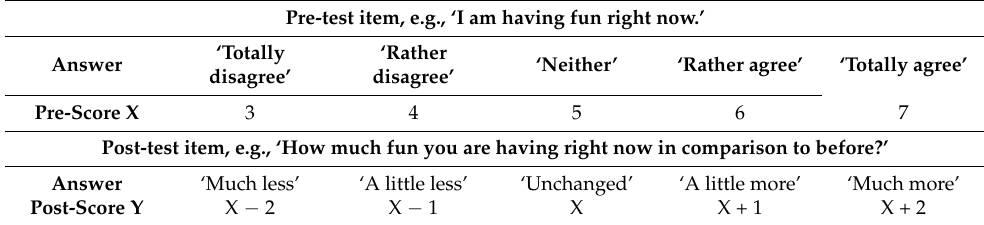
Table A1. Data transformation for activity-related achievement emotions assessment.